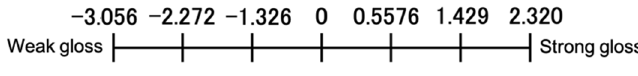
Figure 14. Rating scales after scale construction.